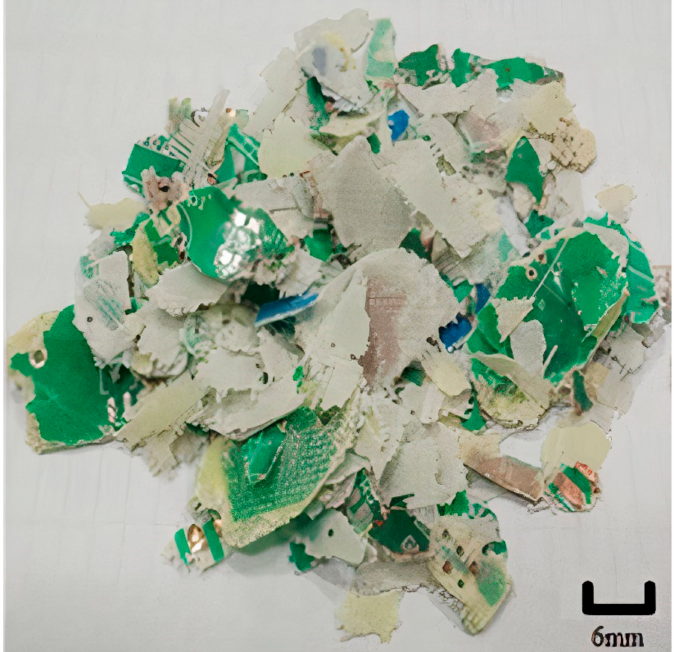
Figure 5. Non-liberated PCB particles after mechanical pre-treatment. Reused from [53] with permission from Waste Management.